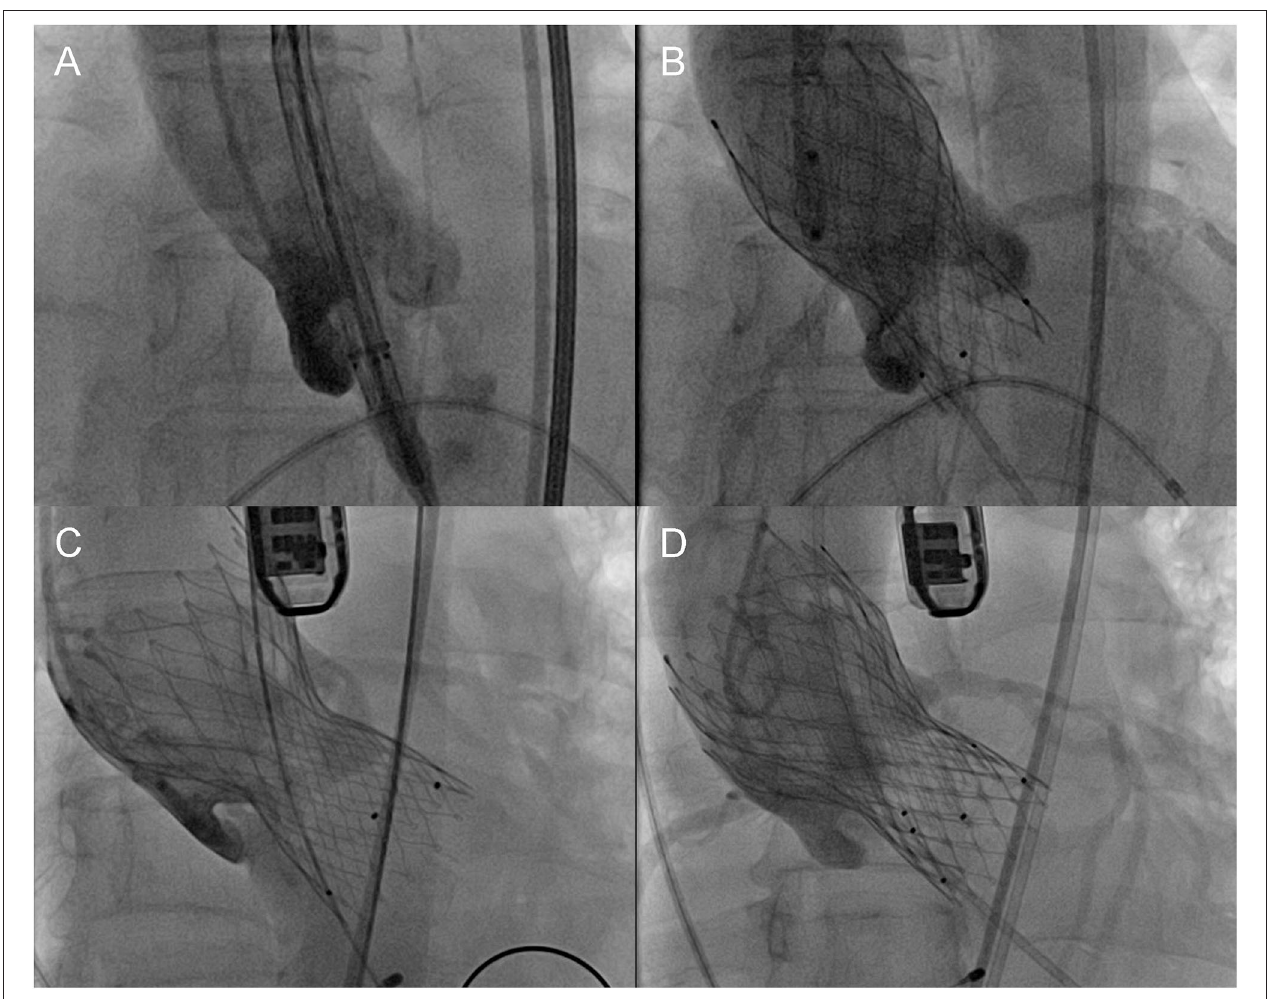
FIGURE 1 | Definition of different positions of the prosthesis. (A) Initial position, (B) optimal position, (C) malposition, and (D) implantation of a second